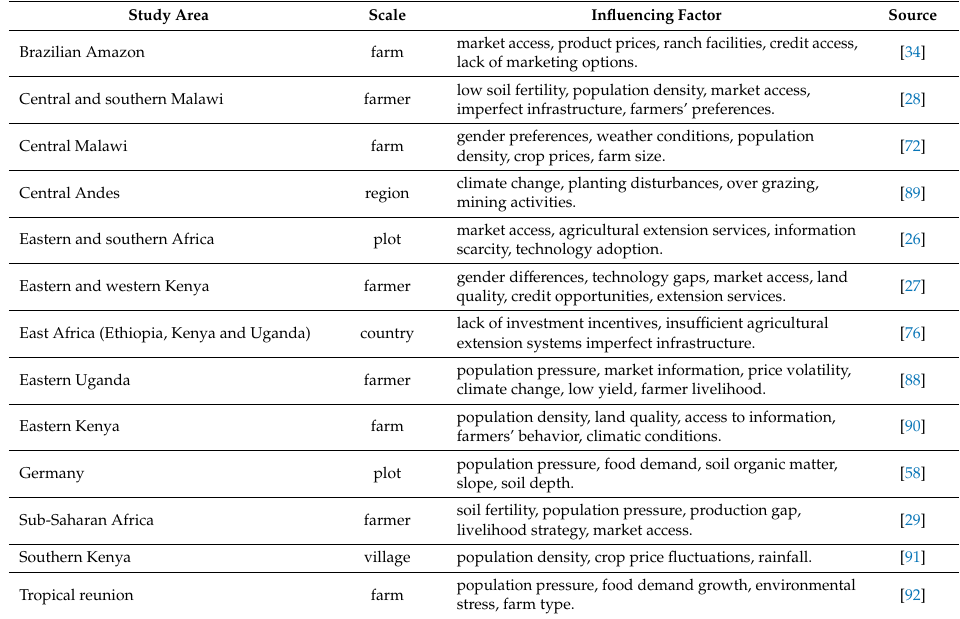
Note: Table A2 in the Appendix A excerpts papers that have made significant contributions to the study of agricultural sustainable intensification. Including authors, journal, publication year, number of indicators used, nature of indicators, scale of application, influencing factors,